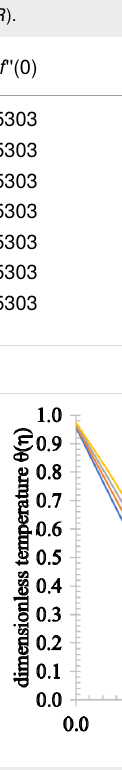
Figure 2: The velocity profile of a fluid for increasing values of the Hartmann number, Ha .